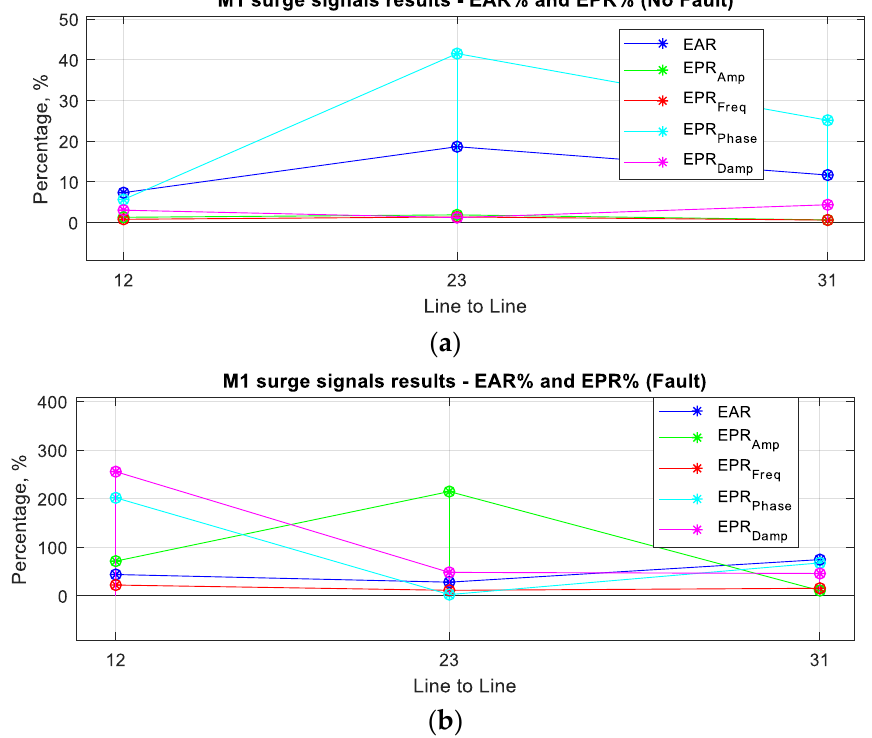
Figure 9. EAR% and EPR% index results comparison of M1 surge signals. ( a ) No fault ( b ) Fault. In Figure 10, the %EPR Amp , %EPR Freq , and %EPR Damp also have a low value in compar- ison with the %EAR for a no-fault condition of Motor 2, as shown in Table 7, but the